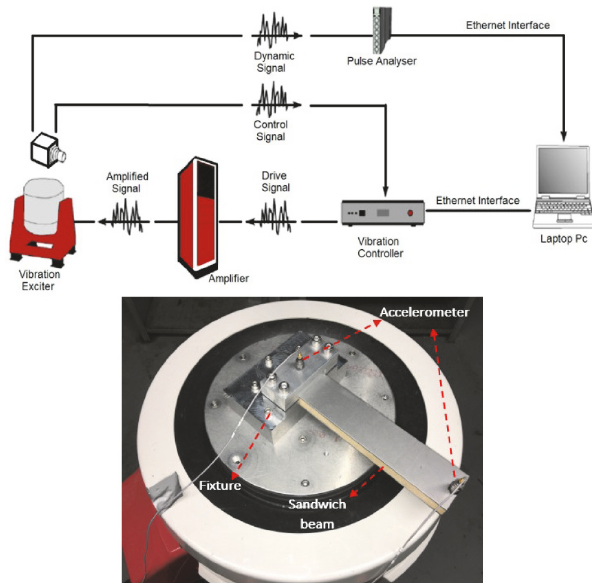
Figure 8: Schematic of experimental setup.